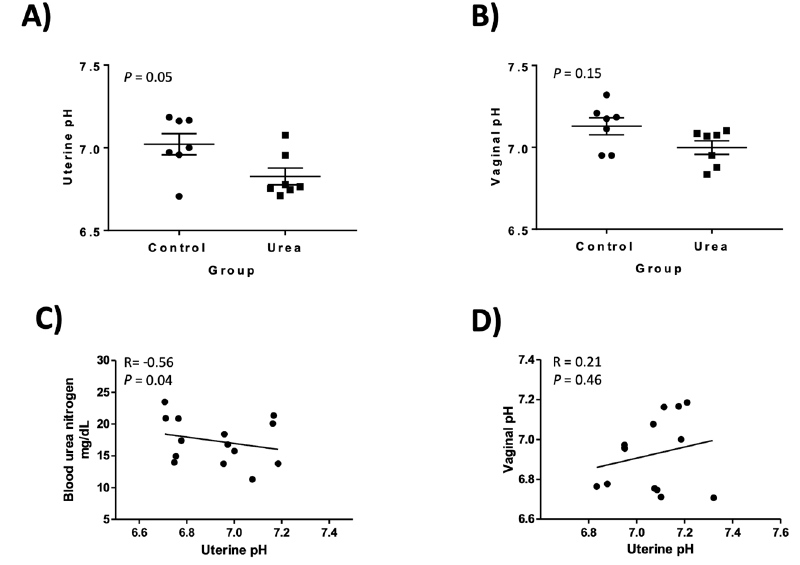
Figure 2. Uterine pH ( A ) and vaginal pH ( B ) analyzed in diestrus mares receiving an intravenous control or urea treatment over 6 h done in a crossover design. Horizontal line represents mean ± SEM. ( C ) Correlation between blood urea nitrogen (BUN, mg / dL) concentrations at hour 6 and uterine pH. ( D ) Correlation between uterine and vaginal pH at hour 6.